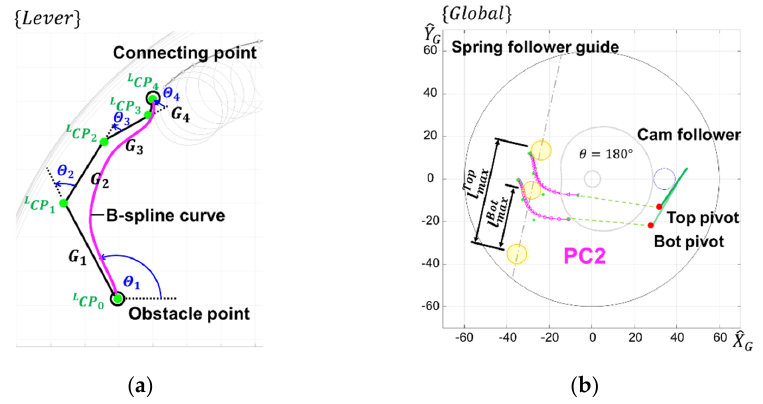
Figure 6. Design of the PC2. The unit of the x- and y-axes are mm: ( a ) B-spline modeling to design PC2 using optimization; ( b ) maximum compression of the spring at each top and bottom pivot position, which constitute the objective function.